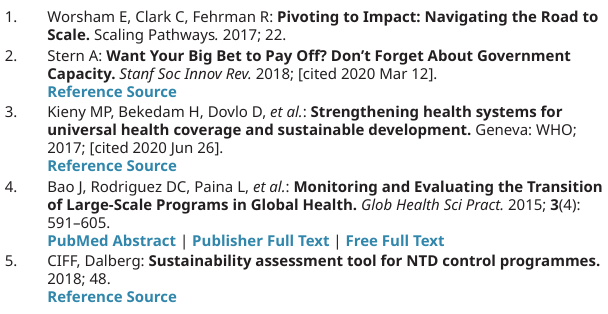
Transition Readiness Assessment Solution 1, Figshare: Transition Readiness Assessment Solution 2,